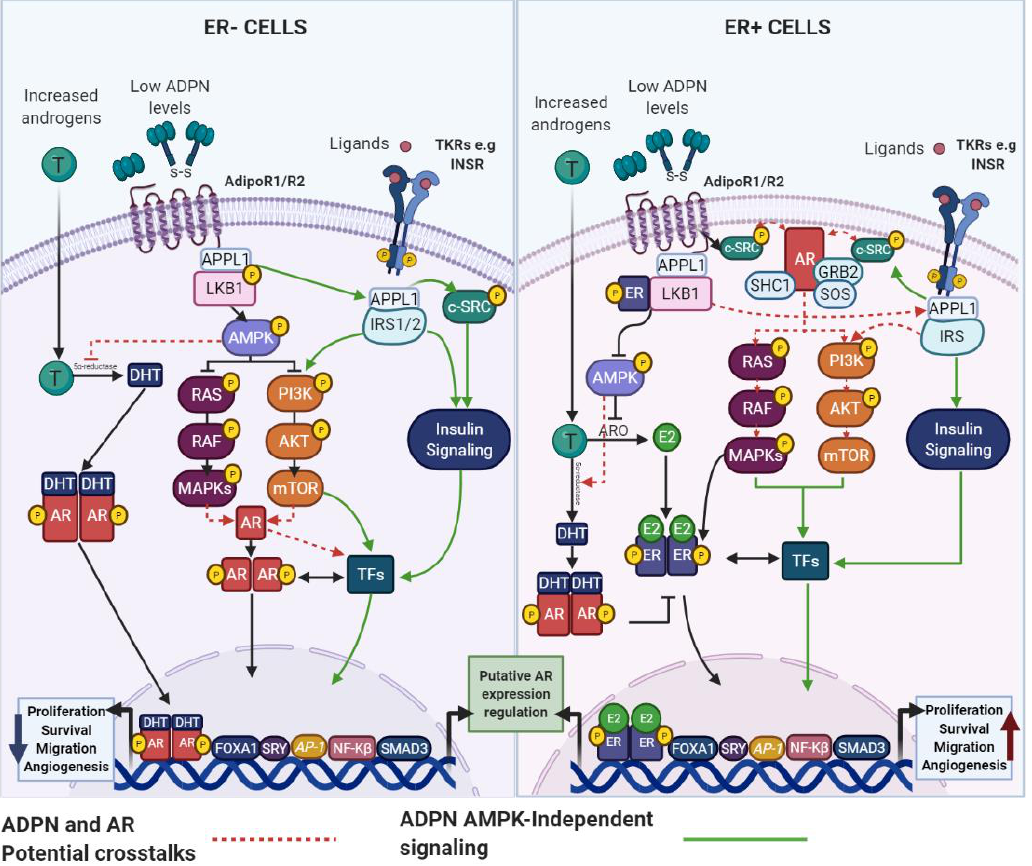
Figure 5. Potential links between ADPN and AR signaling. ADPN and the AR activate common signaling pathways and the crosstalk between them may be involved in regulating BC development, that is dependent on the ER status. INSR—insulin receptor; SRY—sex determining region